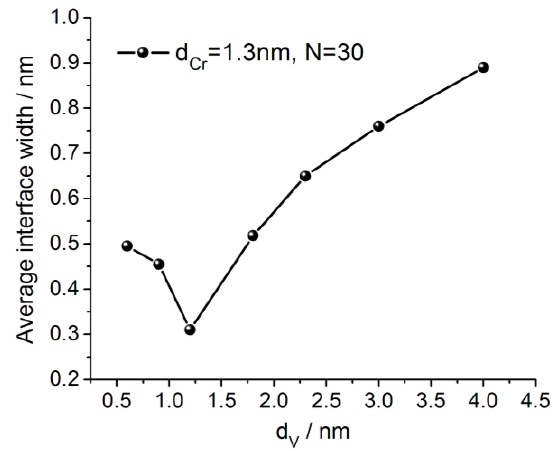
Figure 3. The average interface width versus the vanadium layer thickness.